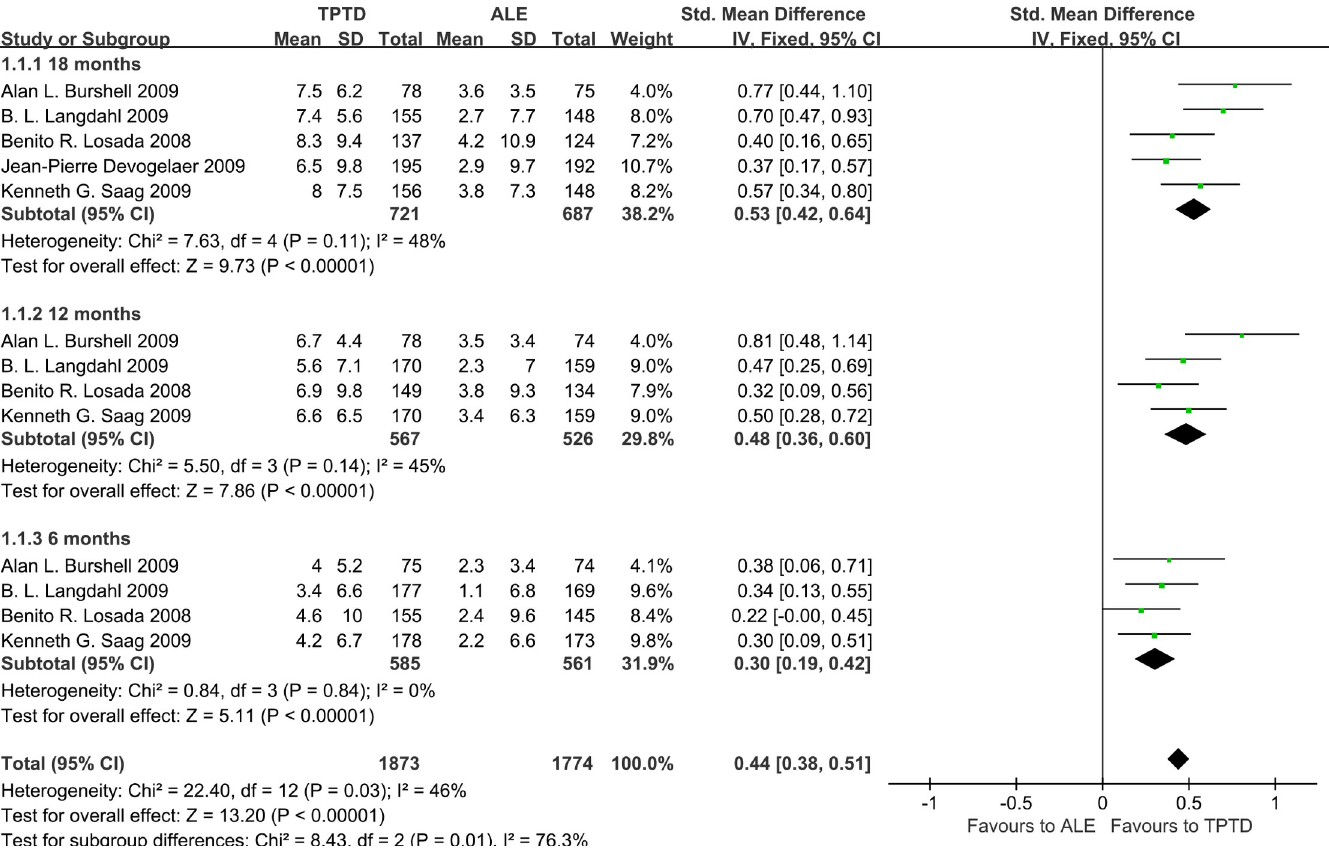
PLOS ONE | https://doi.org/10.1371/journal.pone.0267706 May 31,